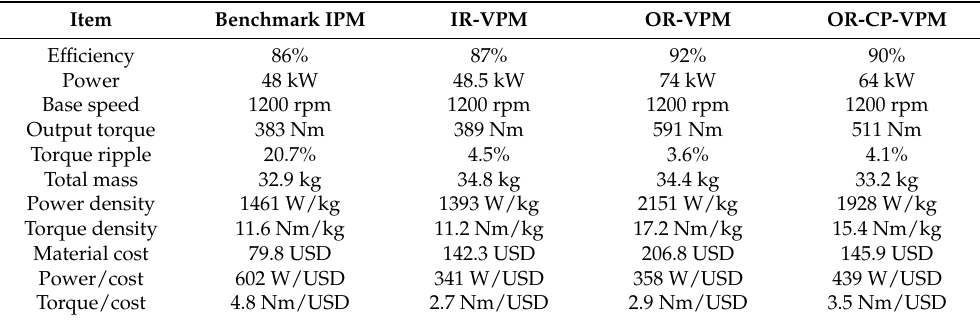
Table 2. Motor performance